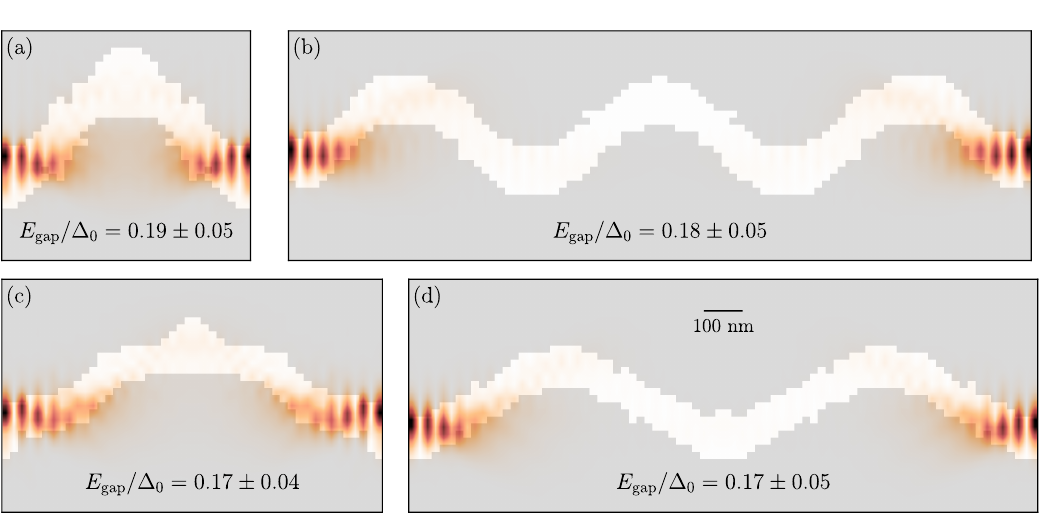
Figure 7: Optimized geometries starting from supercell sizes of (a) 650nm, (b) 1950nm, (c) 975nm, and (d) 1625nm. The remaining optimization and